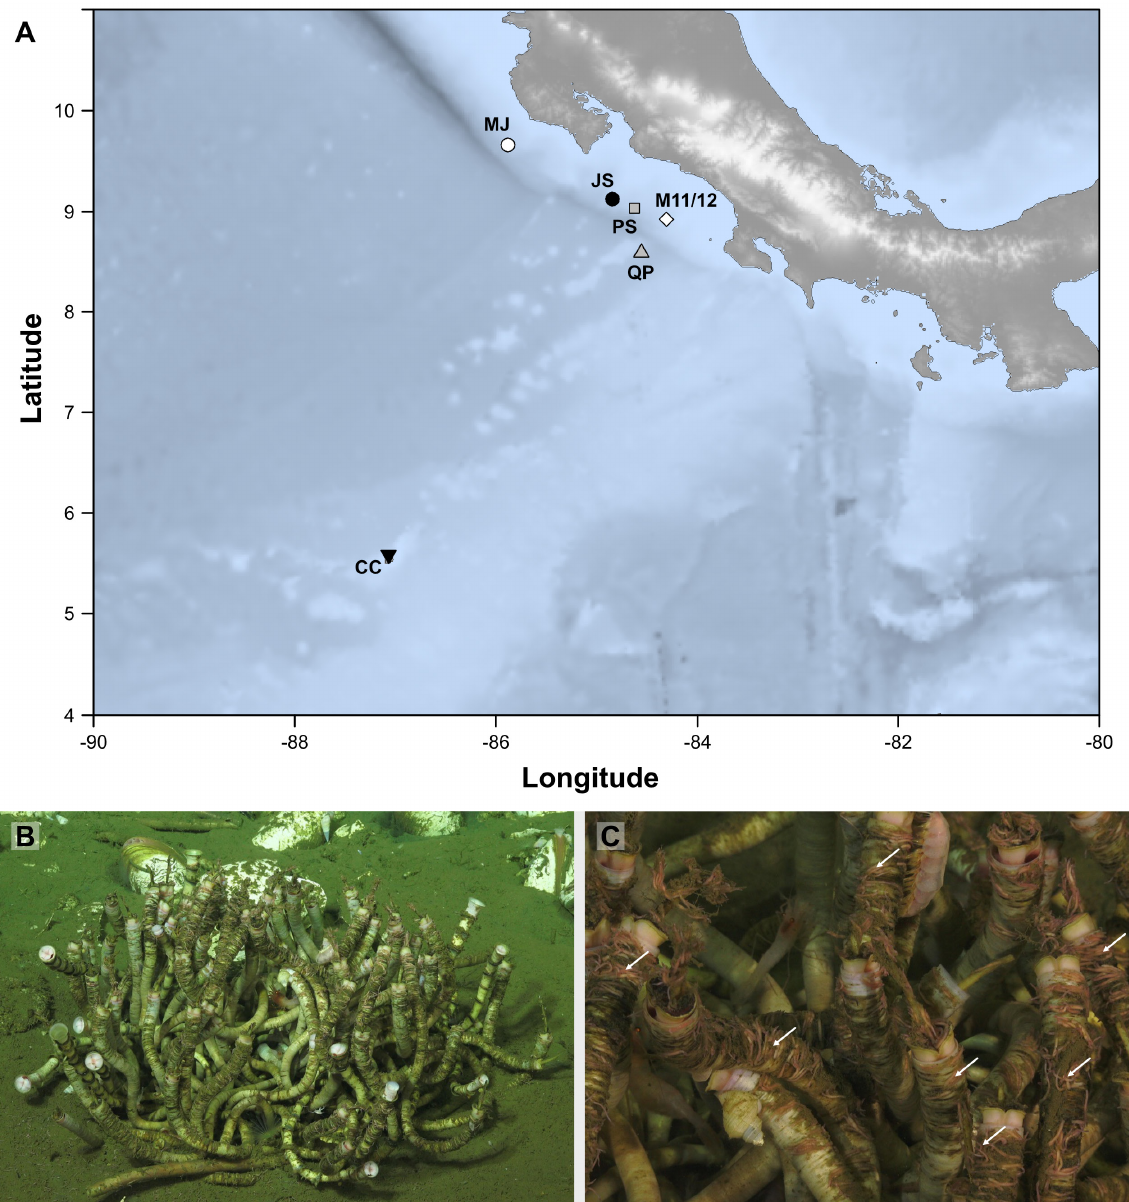
Fig. 1. Sampling sites along the Costa Rica margin and exemplary habitat pictures. A . Map of the seven sampling sites along the Costa Rica margin: Cocos Canyon (CC), Jaco Scar (JS), Mound 11 (M11), Mound 12 (M12), Mound Jaguar (MJ), Parrita Seep (PS), and Quepos Plateau (QP). B . Aggregation of the vestamentiferan Escarpia spicata Jones, 1985. C . Nemerteans of the species Chernyshevia escarpiaphila sp. nov. (arrows) found on Escarpia spicata . Photo credit: ROV SuBastian /Schmidt Ocean